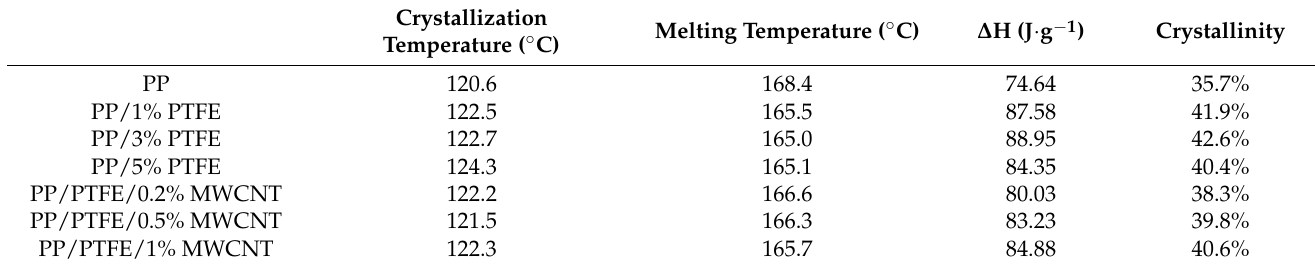
Figure 6c,d plots the DSC curves of PP/PTFE composites with different contents of MWCNTs during heating and cooling. It can be seen that with the addition of MWC- NTs, the crystallization temperature and crystallinity are basically unchanged; this is